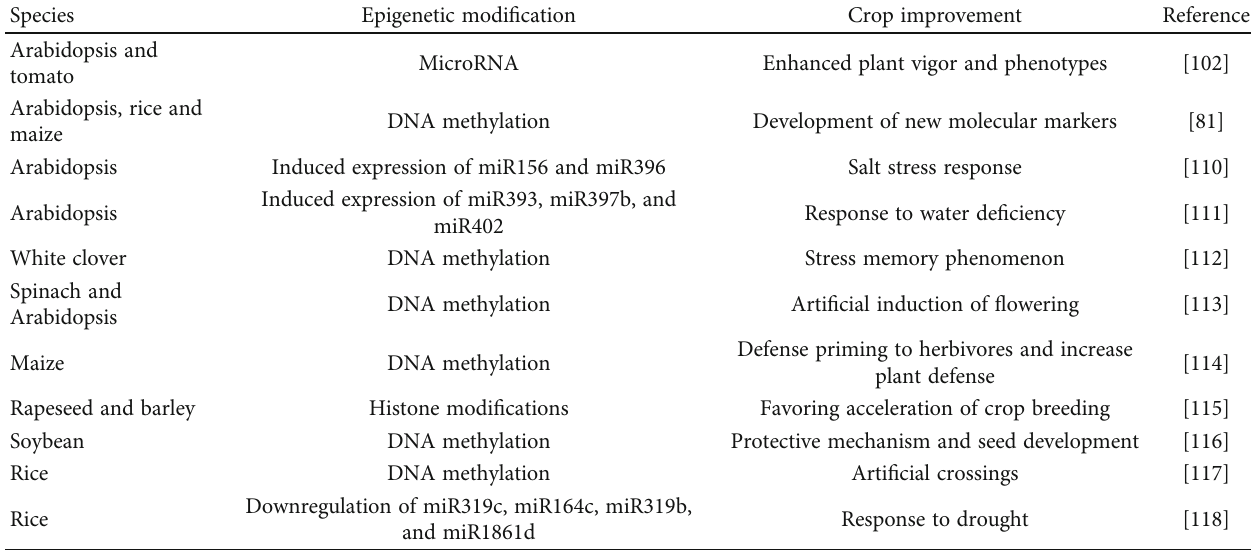
Table 2: Epigenetics for crop